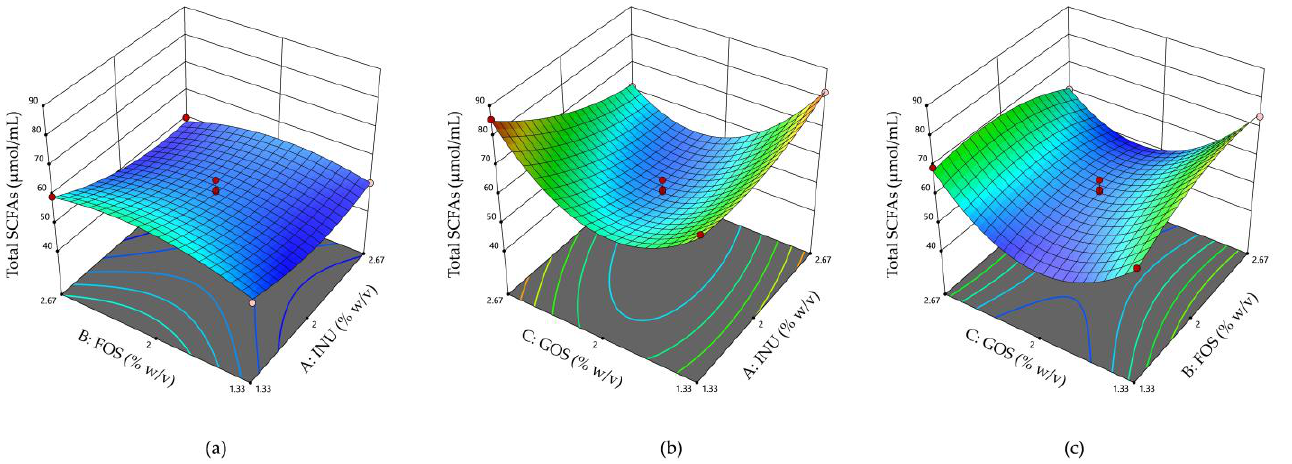
Figure 7. Response surface plots of the total SCFAs for the interactions between the independent factors: ( a ) effect of INU and FOS; ( b ) effect of INU and GOS; and ( c ) effect of FOS and GOS. Table 5. Fit statistics of the PI score and total SCFAs with a Box–Behnken design (BBD) experi-